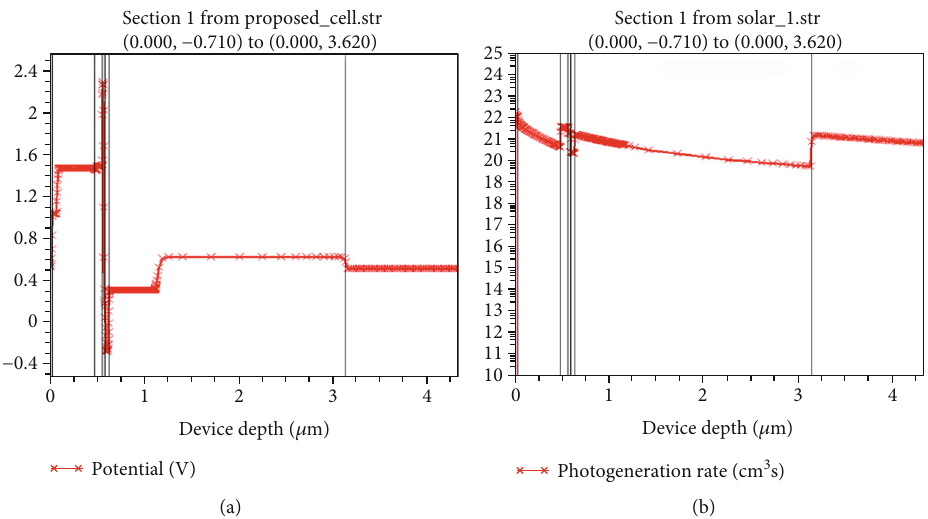
Figure 12: Cutline view of the (a) electrostatic potential and (b) logarithmic distribution of the photogeneration rate in the cell. Table 4: Summary of the extracted electrical performance parameters for the optimized InGaP/GaAs DJ solar cell using Al (Al Ga ) In P. 0.7 0.3 0.5 0.5